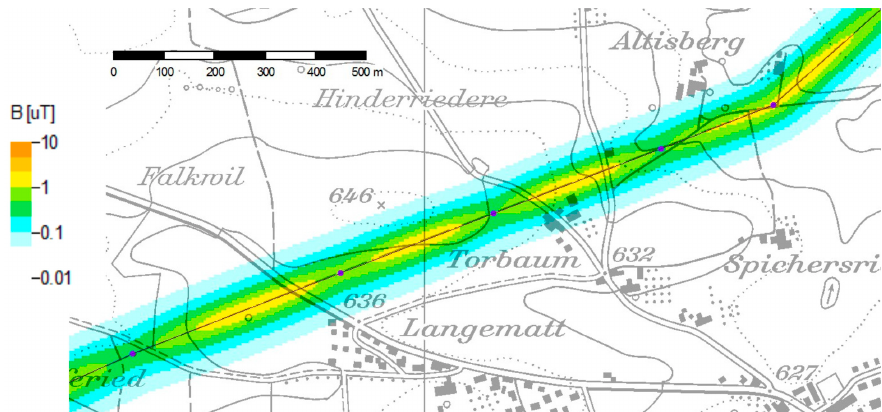
Figure 5. Detailed result of a color ‐ coded magnetic field map produced in the pilot project. Background map PK25 © Swisstopo.